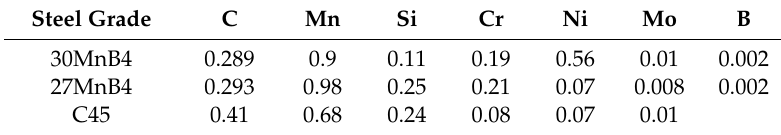
Table 2. Chemical composition of investigated